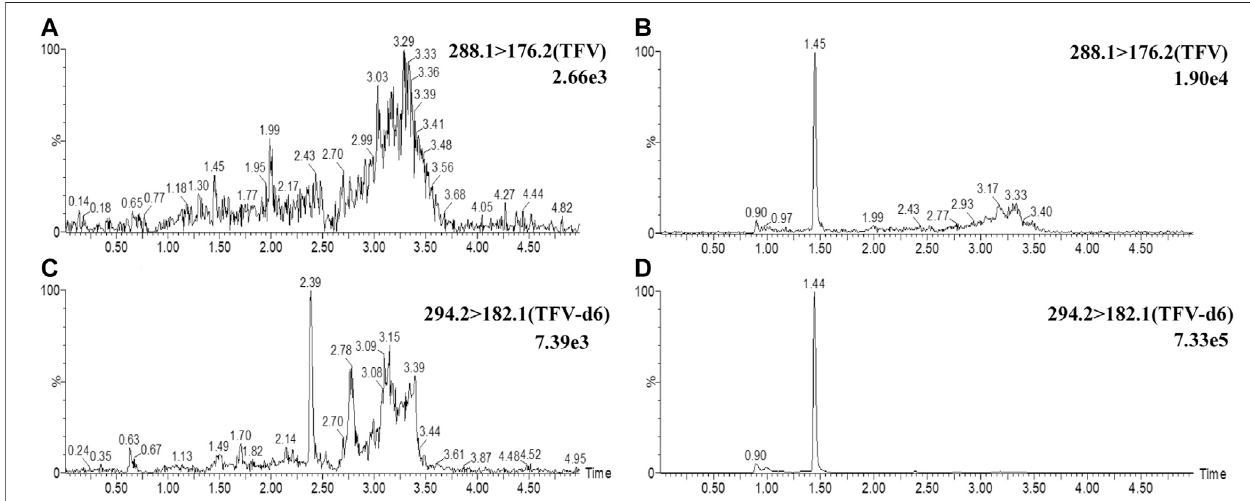
FIGURE 1 | Representative UPLC-MS/MS chromatograms of TFV and IS. Chromatograms of TFV were demonstrated at m/z 288.1 → 176.2 channel in blank breast milk samples (A) and blank breast milk samples spiked with 0.5 ng/ml TFV. (B) Chromatograms of IS were demonstrated at m/z 294.2 → 182.1 channel in breast milk (C) and blank breast milk spiked with 2.5 ng/ml IS(D).